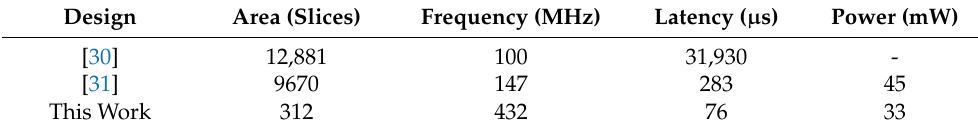
Table 7. Synthesis results for the proposed key exchange protocol hardware architecture.